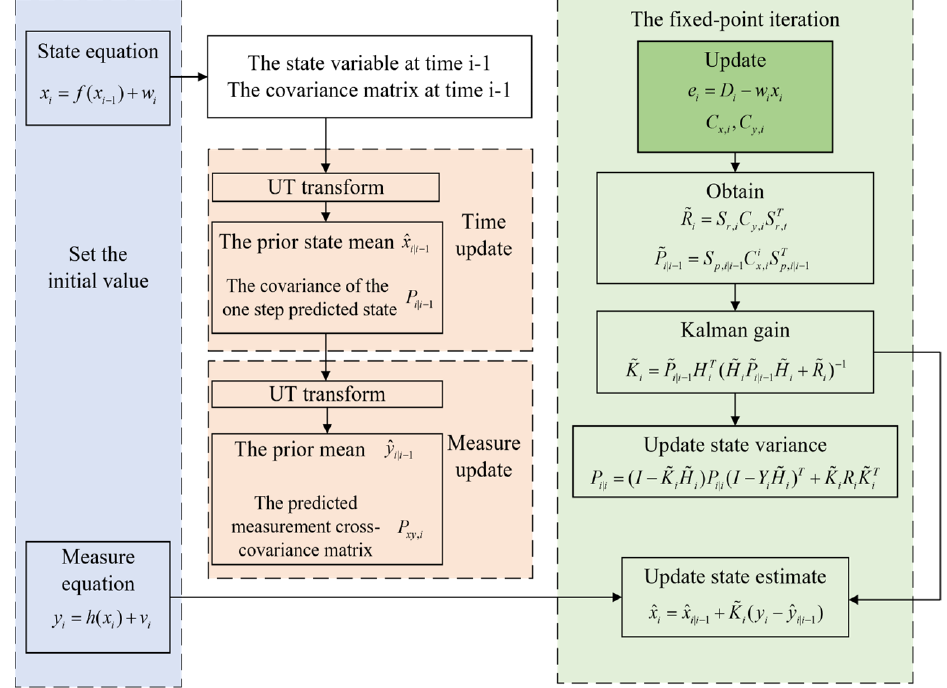
Figure 1. Schemes following the same format. The initial value of the nonlinear measurement system, the state equation, and the measurement equation are set, and then the prior state mean value a and one step prediction covariance matrix b are obtained by the unscented transformation (UT) according to the state variable and estimated deviation covariance matrix at time i − 1 in the time update. Similarly, in the measurement update, the prior mean and measurement cross covariance matrix can be obtained through UT transformation according to these variables. Finally, the Kalman gain and updated covariance matrix can be obtained through indeterminate − point iteration and updated state estimates [21]. The specific discussion on the establishment of the fixed point iterative equation is as